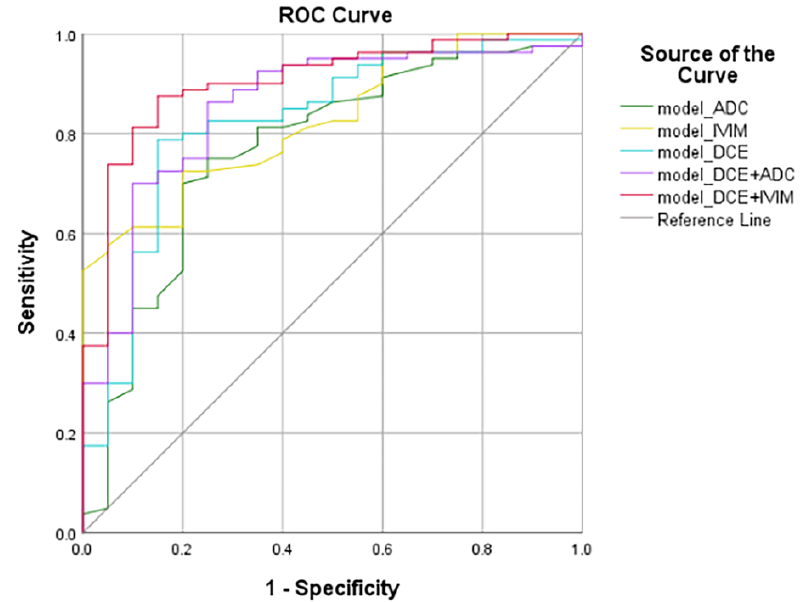
Figure 2. ROC curves of the models. The ROC curves were generated by models based on: ADC – DWI, IVIM, DCE – MRI, DCE – MRI + ADC – DWI, DCE – MRI + IVIM. ROC, receiver operating charac- teristic. Table 4. Diagnostic performance of the models.